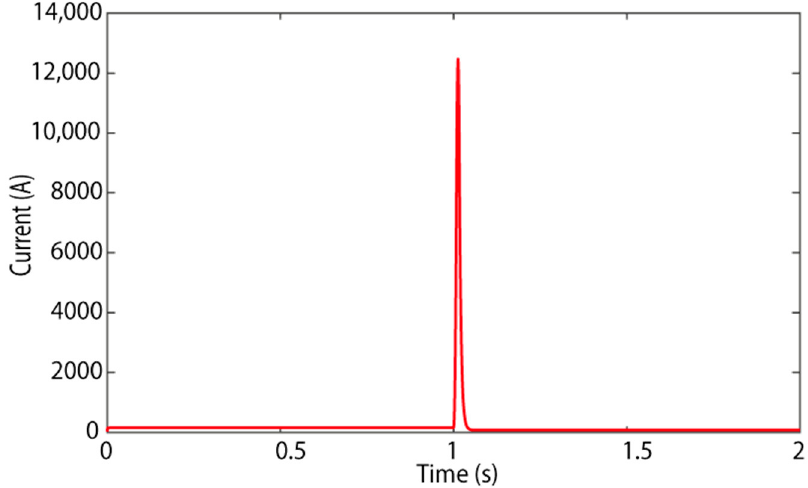
Figure 13. Current through CB5 during fault with cyber-attack on CB5.